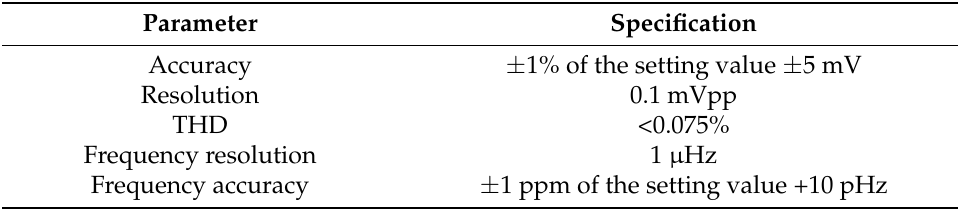
Table 2. RIGOL DG952 AWG output characteristics [35].